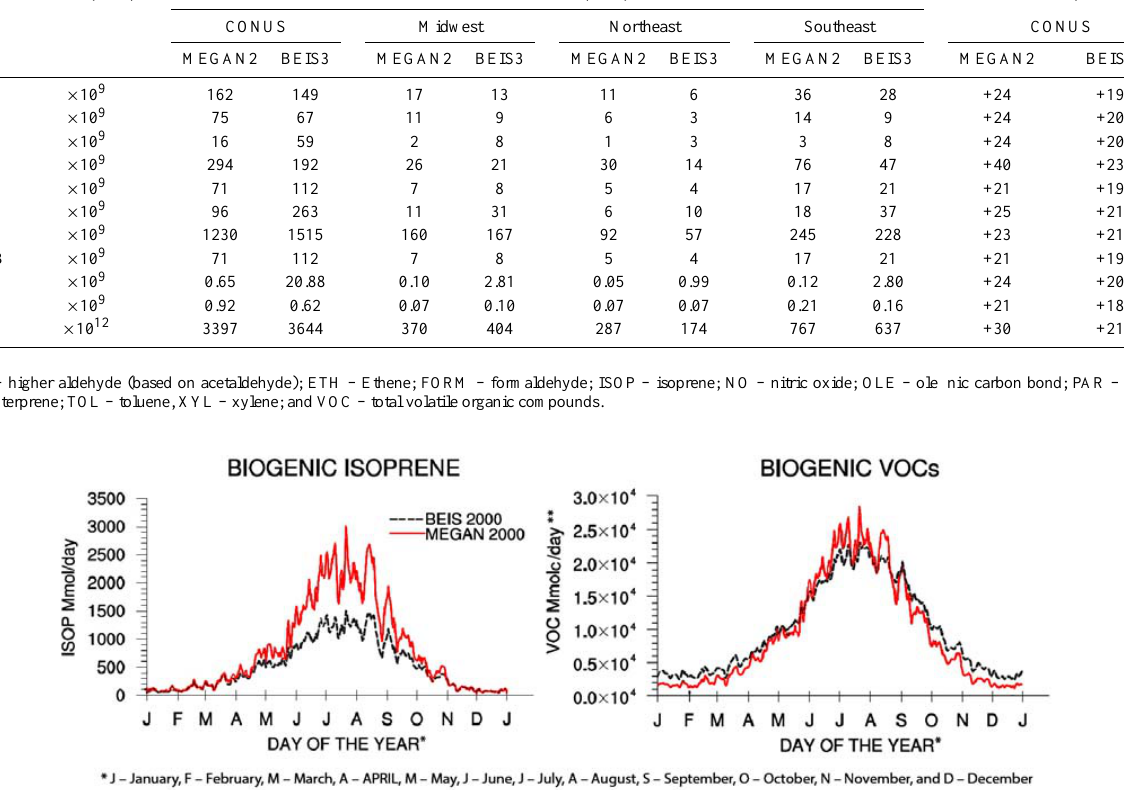
Fig. 3. Average seasonal change in PBL height difference between 2049-2051 and 1999-10 2001 from MM5 outputs: (a) JFMA, (b) MJJAS, and (c) OND.